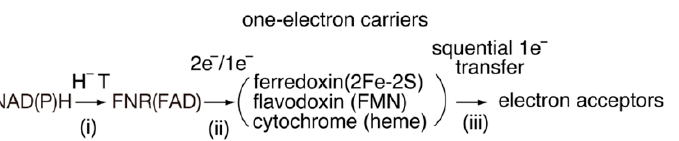
Figure 3. Proposed catalytic cycle of the eukaryotic-membrane-bound cyt P450 reductase-cyt P450 system. In this figure, the overall reaction is based on the catalytic cycle. Note that cyt P450R indi- cates cyt P450 reductase. H − T, hydride transfer; 1e − T, one-electron transfer; PC1e − T, proton-coupled one-electron